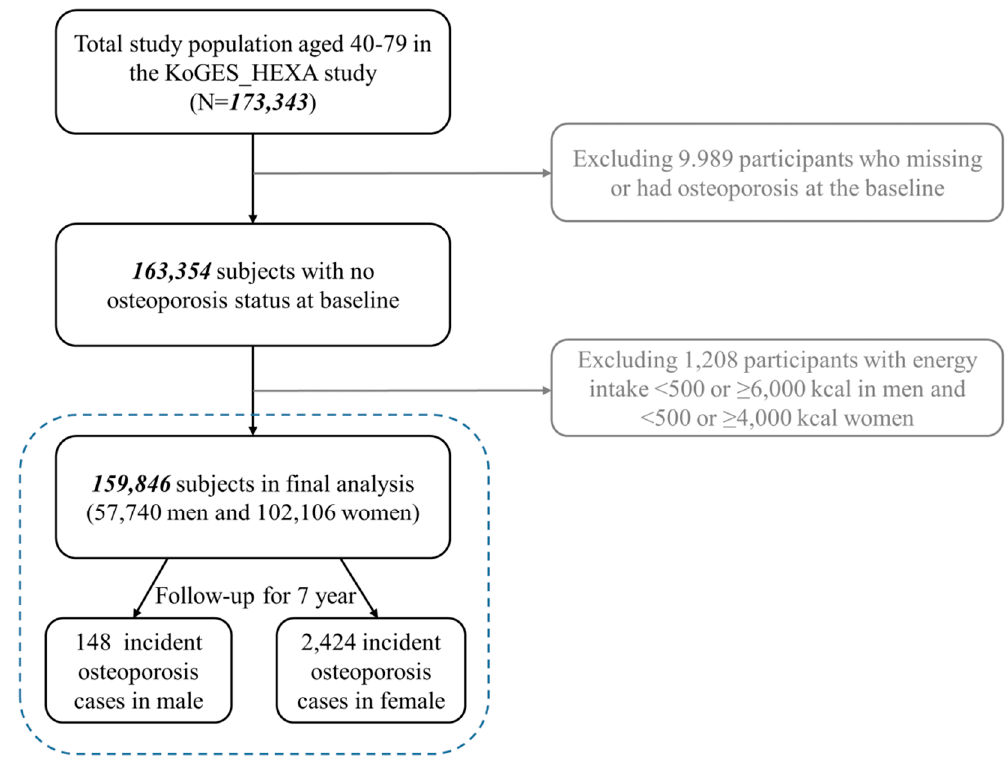
Figure 1. Flow chart of the analytical samples in the present study. KoGES_HEXA, Korean Genome and Epidemiology Study_Health Examinee